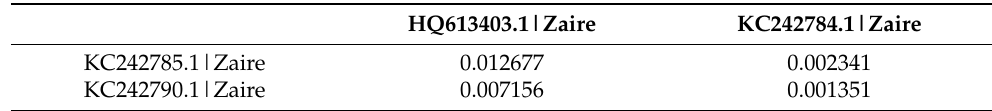
Table 6. The p -values for testing the nucleotide substitution number between sequences in the second clade for the tree in Figure 9B.